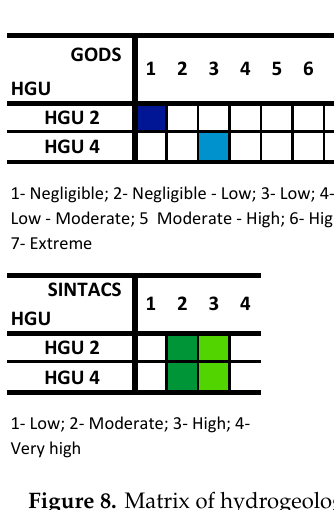
for contamination in the Penafiel urban area (NW Figure 8. Matrix of hydrogeological units and each of five potential groundwater vulnerability